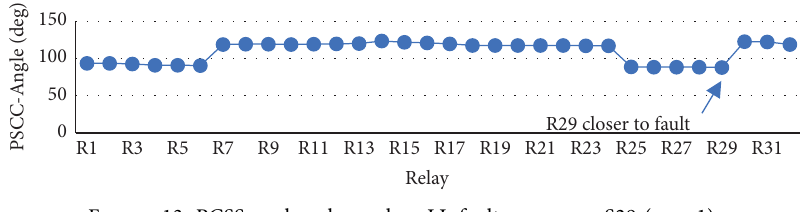
Figure 13: PCSS angle values when LL fault occurs on S29 (case 1). Table 3: DERs allocation and power losses reduction.